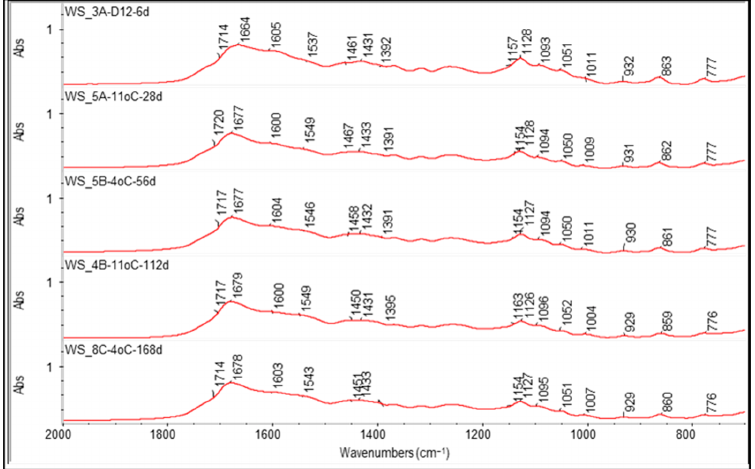
Figure 1. Fourier-transform infrared spectra in 2000–700 cm − 1 spectral region of A, B and C cheese water-soluble extracts of five different classes, according to days of ripening; 6d, 6 days; 28d, 28 days; 56d, 56 days; 112d, 112 days; 168d, 168 days; A, full-fat sheep milk cheese; B, reduced-fat sheep milk cheese; C, reduced-fat sheep milk cheese fortified with sweet sheep buttermilk. Table 1. Wavenumbers of the 15 peaks distinguished in 1854–1381 and 1192–760 cm − 1 spectral re- gions of cheese water-soluble extracts and functional groups of the substances that absorb, among others, infrared light in the corresponding peak spectral regions.